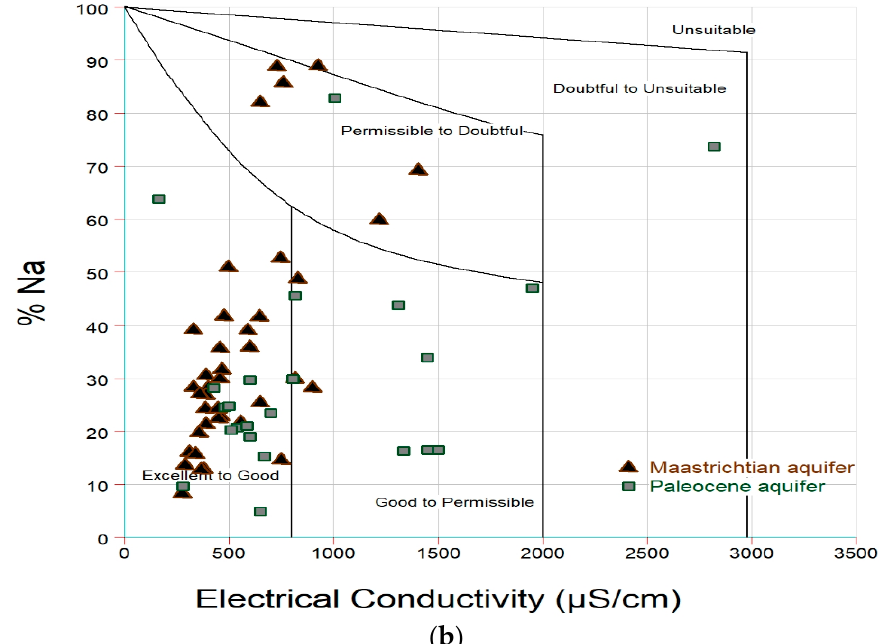
Figure 5. USSL diagram (SAR versus EC plot) ( a ) and Wilcox diagram (Na% versus EC plot) ( b ) of the Maastrichtian and Paleocene groundwater samples (June 2019).